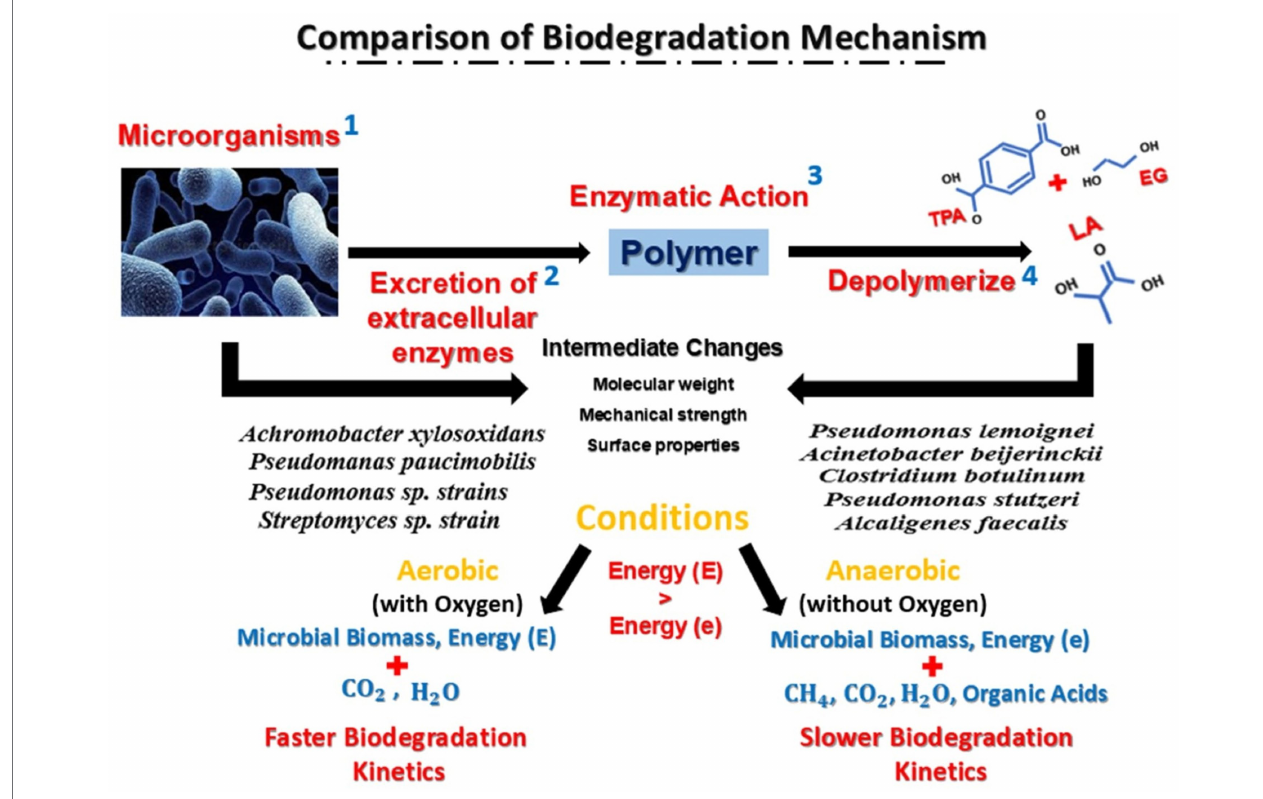
FIGURE 2 | Biodegradation processes of PLA-PET plastic waste under different conditions. Biodegradation occurs under two main conditions: aerobic and anaerobic. For aerobic degradation, oxygen is necessary; in contrast, for anaerobic degradation, oxygen is needed at the start of the process, but not needed after a while. Both conditions use different enzymes that affect the molecular weight, mechanical strength, and surface properties. In one comparison, aerobic degradation occurs much faster than anaerobic degradation (Glaser, 2019). In anaerobic conditions, less energy is released compared with in aerobic conditions. The end products of the degradation are microbial biomass, CO 2 , H 2 O, and energy in aerobic digestion and extra products, namely CH 4 and organic acids in anaerobic